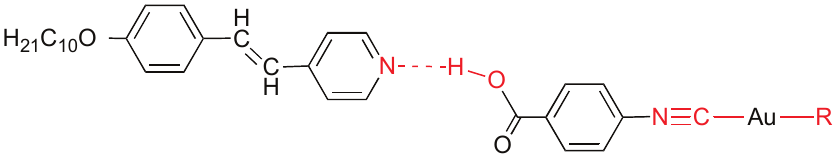
F , C F OC H , C F C F 6 5 6 4 6 13 6 4 6 4